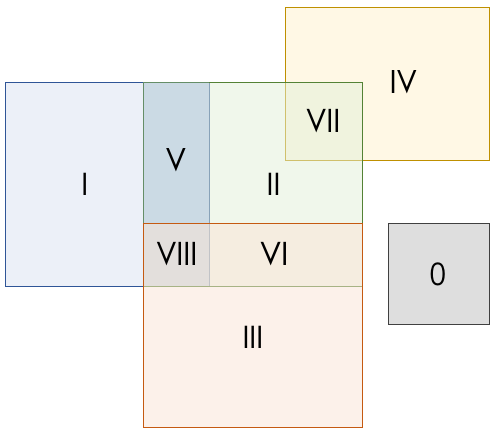
Figure 1 . The five-parametric theory space described by the non-metricity scalar Q decomposes into nine primary sectors. Four sectors, I–IV, emerge directly from the degeneracy of the Hessian, while the sectors V–VIII describe the intersection of two or three different sectors. The unphysical sector 0 lies in the complement of